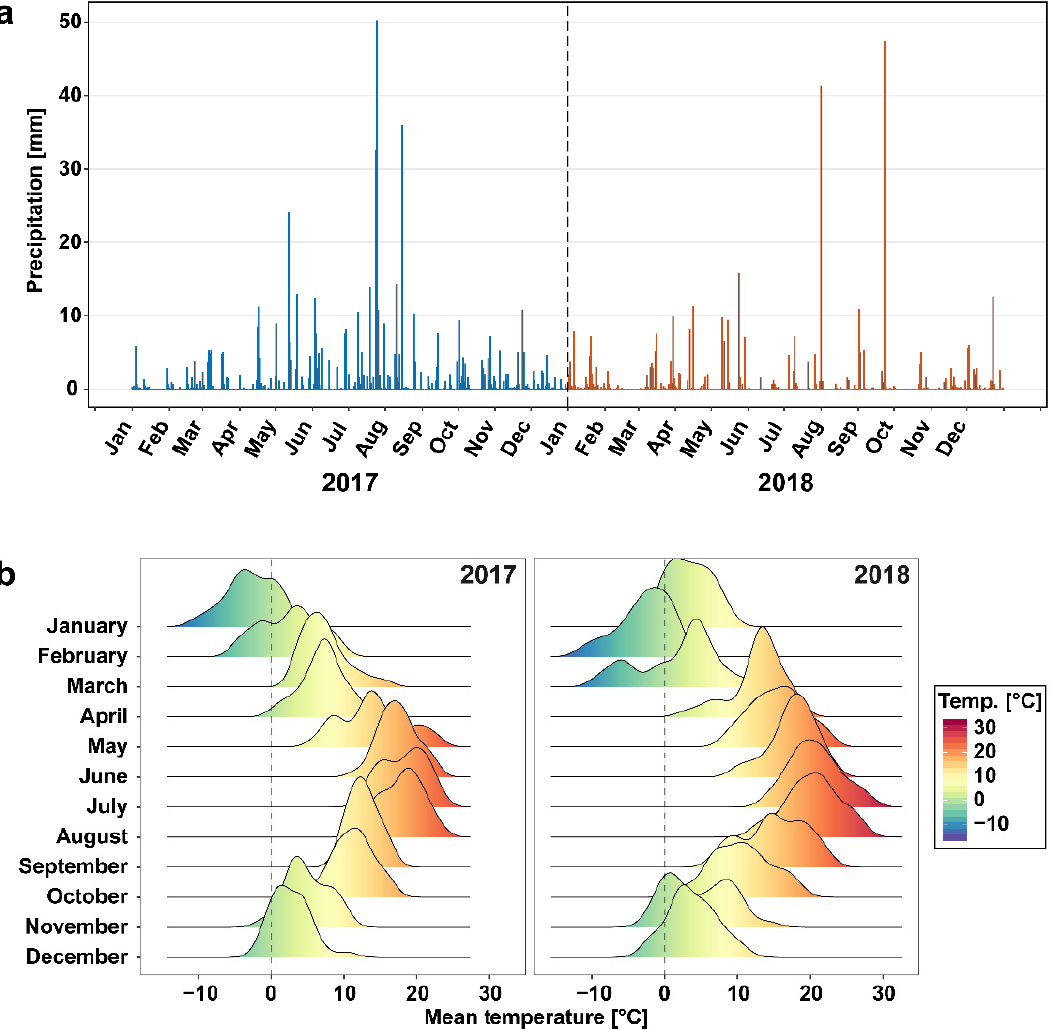
Figure 1. Precipitation and temperature at the sampling site. ( a ) The graph displays the daily precipitation totals (in mm) at the sampling site for the crop years 2017 (blue) and 2018 (red). ( b ) Density plots show the distribution of daily average air temperatures (in ◦ C) for the crop years 2017 (left) and 2018 (right). Raw data were retrieved from the weather station (Erfurt-Weimar, German Meteorological Service) with the closest proximity to the sample origin.